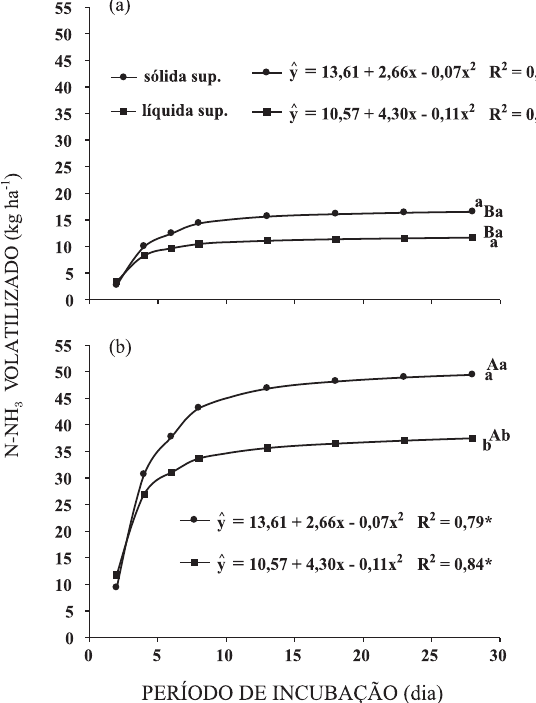
Figura 5. Volatilização acumulada de NH do solo ao 3 longo do tempo após a aplicação sobre a superfície do solo de doses de N (a = 100 kg ha -1 ; b = 190 kg ha -1 ) na forma de ureia convencional ou de ureia com inibidor de urease, no estado sólido (SS) ou líquido (LS). Médias das duas fontes com quatro repetições cada. Letras maiúsculas comparam as médias entre as doses para a mesma forma de aplicação. Letras minúsculas comparam as formas de aplicação para a mesma dose. Letras iguais não diferem entre si a 5 % (p < 0,05) para a mesma dose aplicada. * Significativo (p <